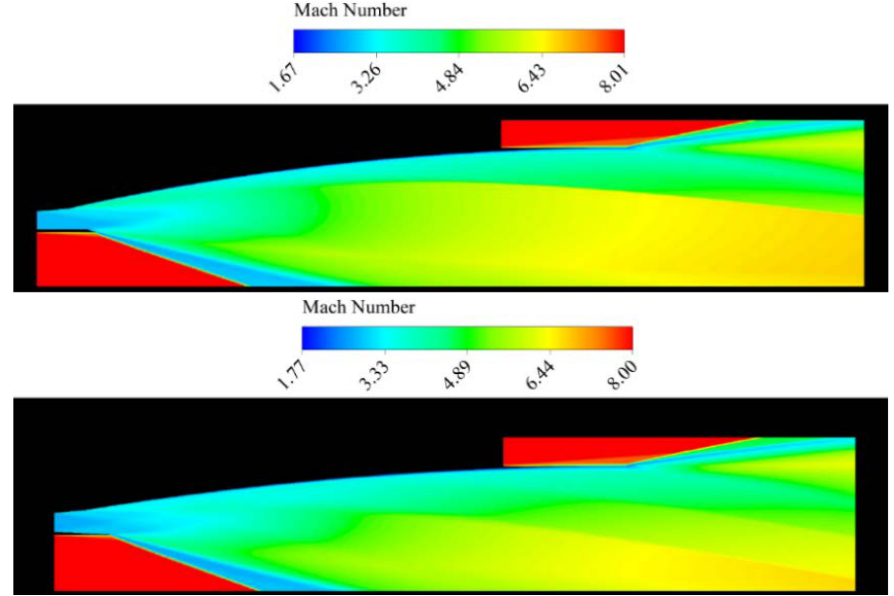
Figure 17. Mach number contours for DP102 ( top ) and DP456 ( bottom ) depicting the kernel region.